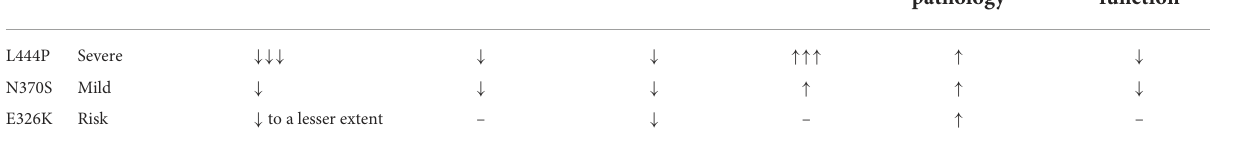
TABLE 1 Overview of the pathogenic mechanisms associated with the most common GBA1 variants associated with PD (L444P, N370S, and E326K). Variant Severity GCase Activity ALP function Lipid homeostasis ER